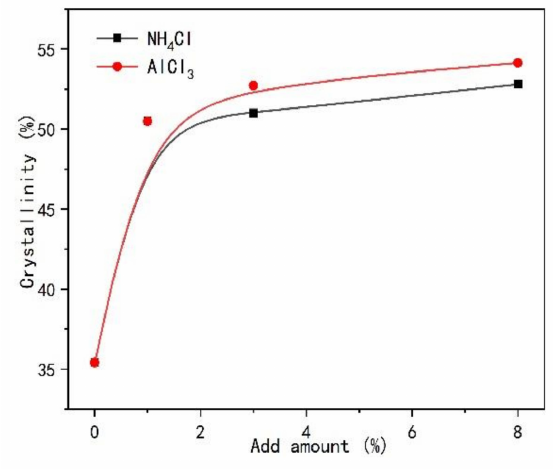
Figure 4. Comparison of crystallinity of UF resin with F/U = 1.0 under the influence of different types of curing agents and addition amounts.